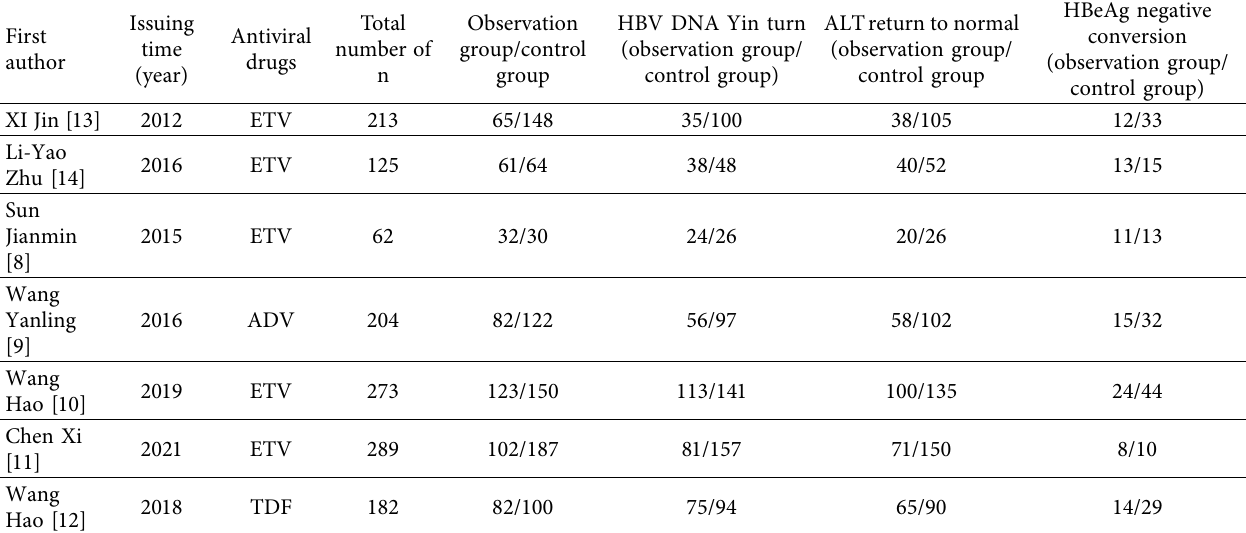
Table 1: Literature’s Basic